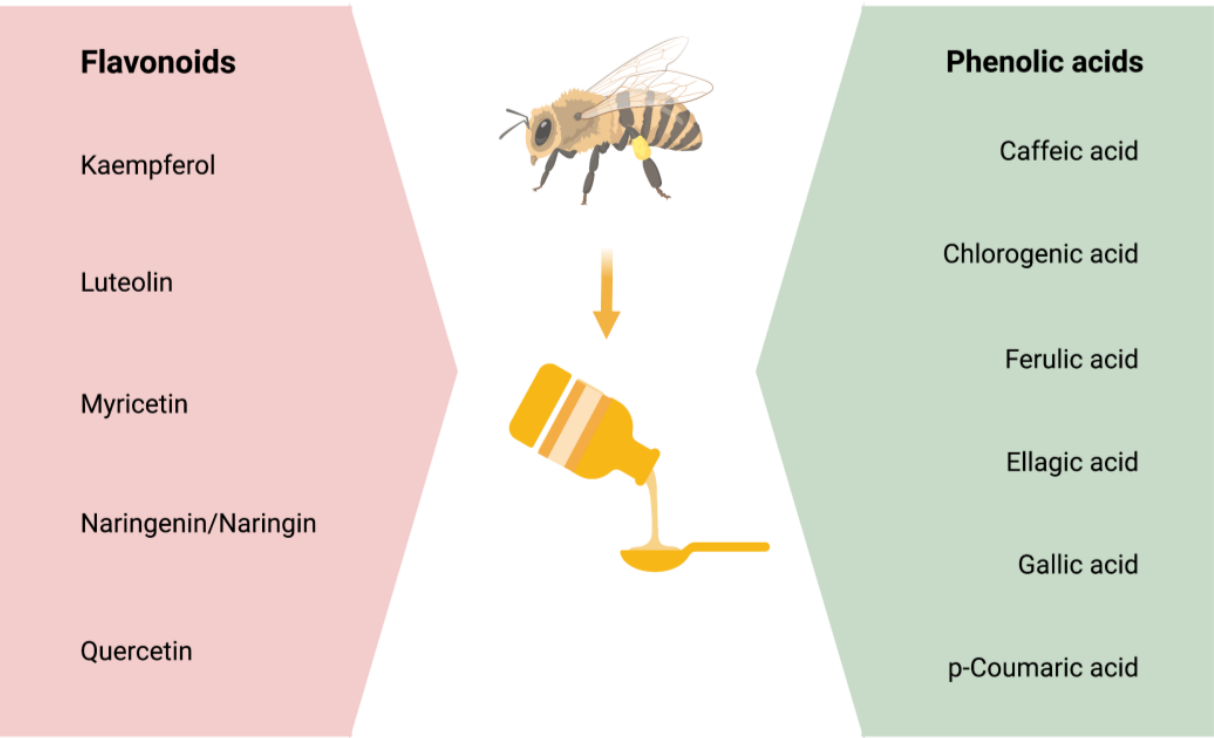
Figure 1. The phenolic compounds, which comprises of flavonoids and phenolic acids.